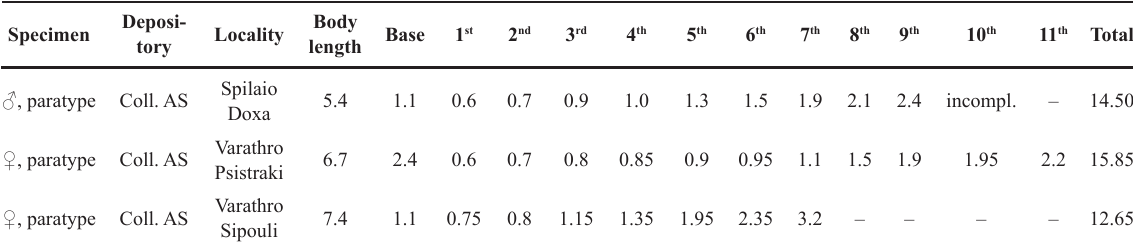
Table 8. Plusiocampa ( Plusiocampa ) hoffmanni Sendra & Paragamian sp. nov. Length of the body, cerci and their articles (measurments in